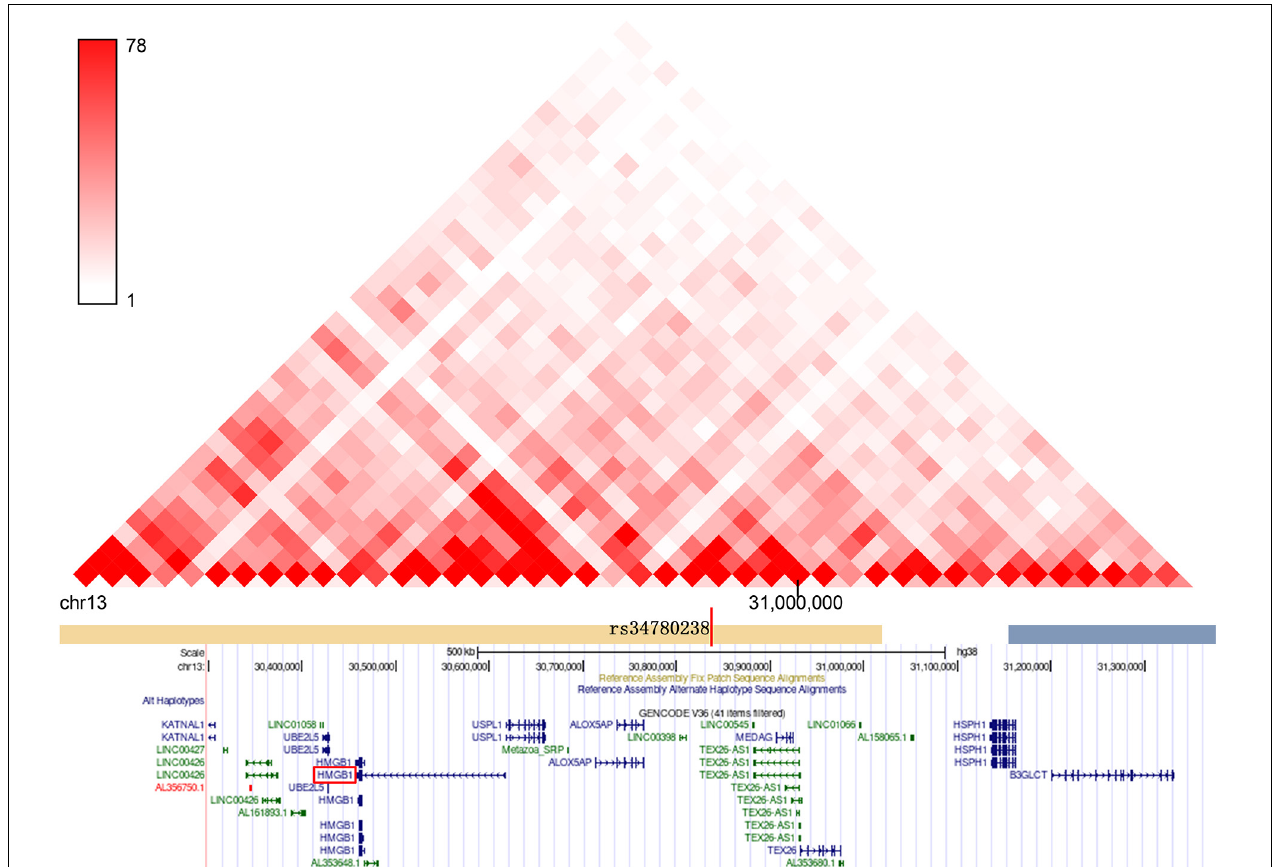
FIGURE 3 | The genome-wide significant SNPs at the novel locus of 13q12.3 and its target genes are located in the same topologically associated domains (TAD).